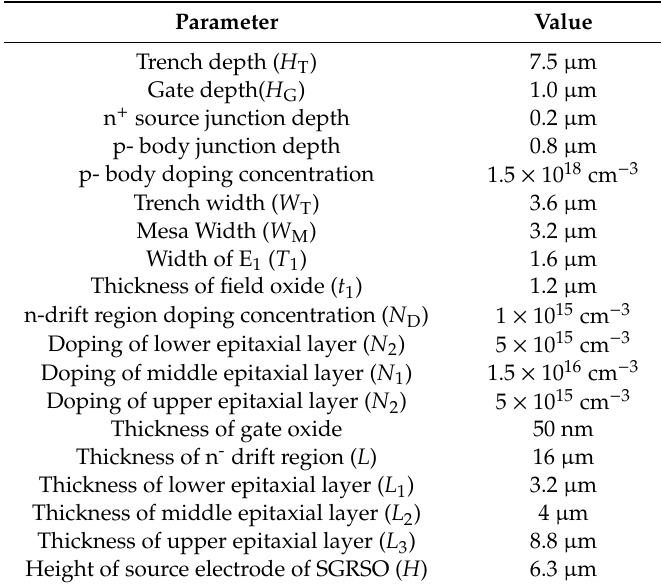
Table 1. Structural parameters adopted in the